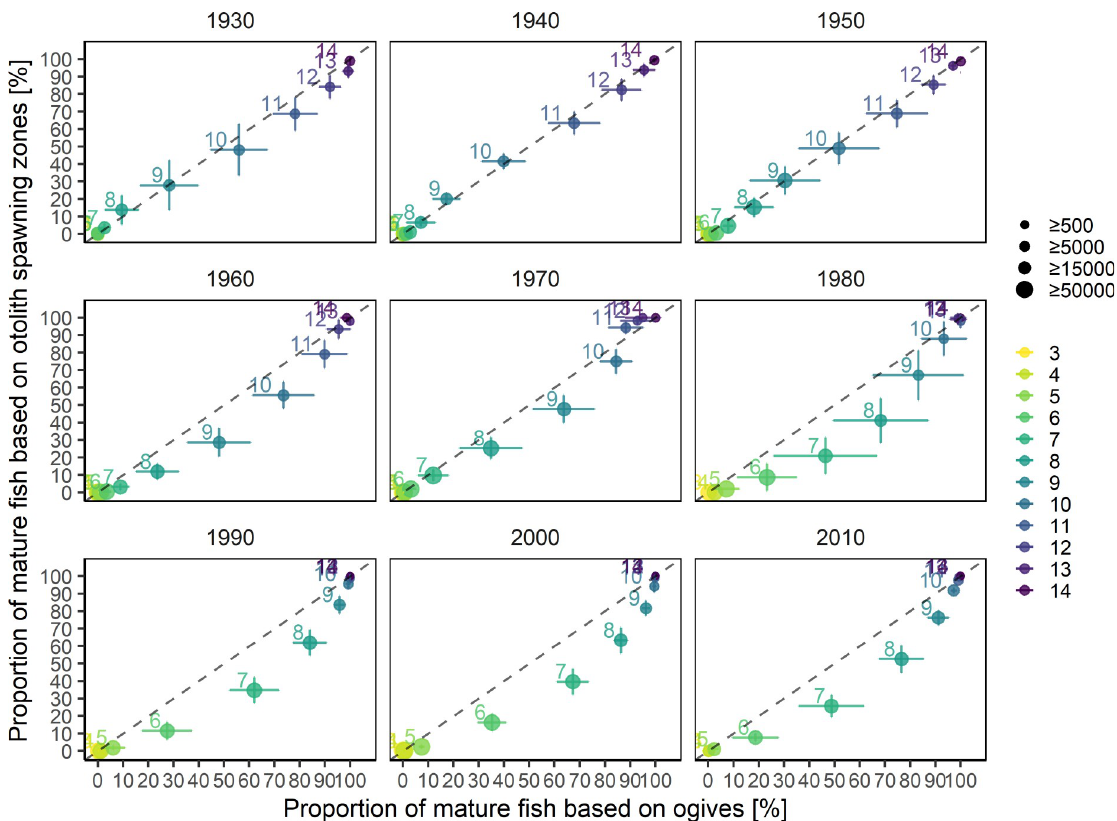
Fig 9. Time series of maturity-at-age derived from spawning zones and from gonads. Mean proportions of NEA cod mature-at-age (colors) calculated from individual increments from the whole archive identified as spawning zones for each year, compared to the mean proportions of mature-at-age calculated from the maturity ogives from stock assessment and aggregated by decade (facet). Error bars indicate the standard deviation of maturity ogives from spawning zones (vertical) and stock assessment (horizontal) within each decade. Point size is proportional to the number of individual increments per age